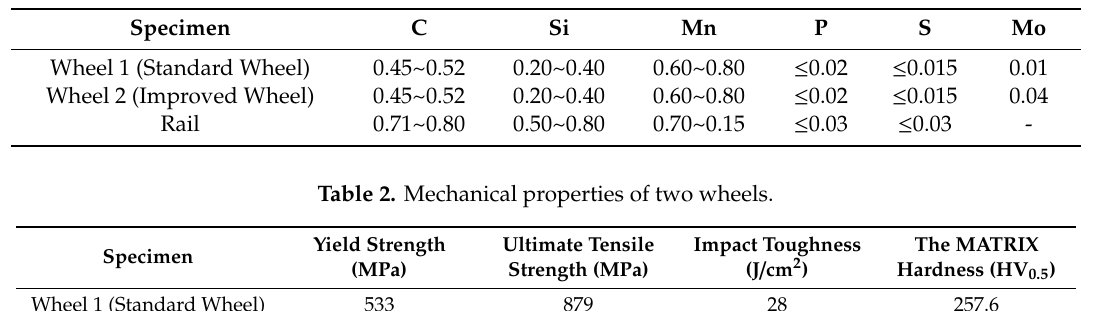
Table 1. Chemical compositions of wheel and rail materials (wt.%).